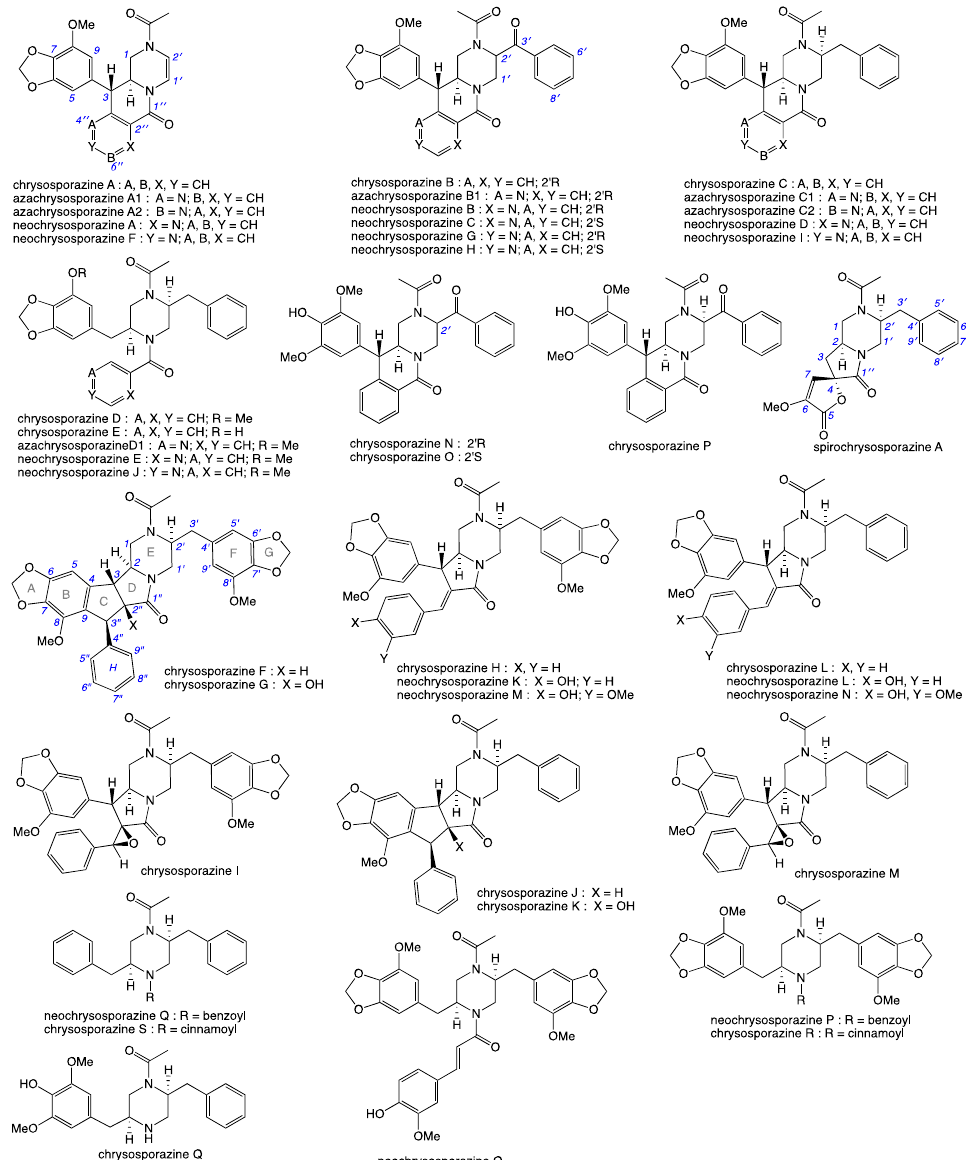
Figure 1. Previously reported chrysosporazines, azachrysosporazines, spirochrysosporazine and neochrysosporazines.